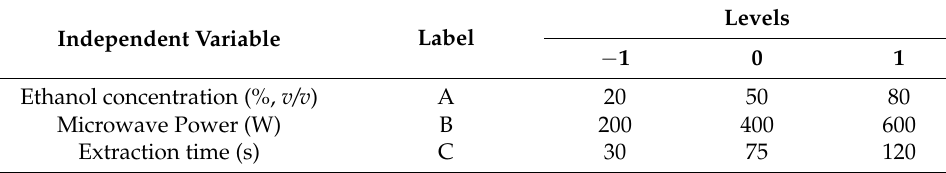
Table 5. Independent variable for the Box–Behnken design.